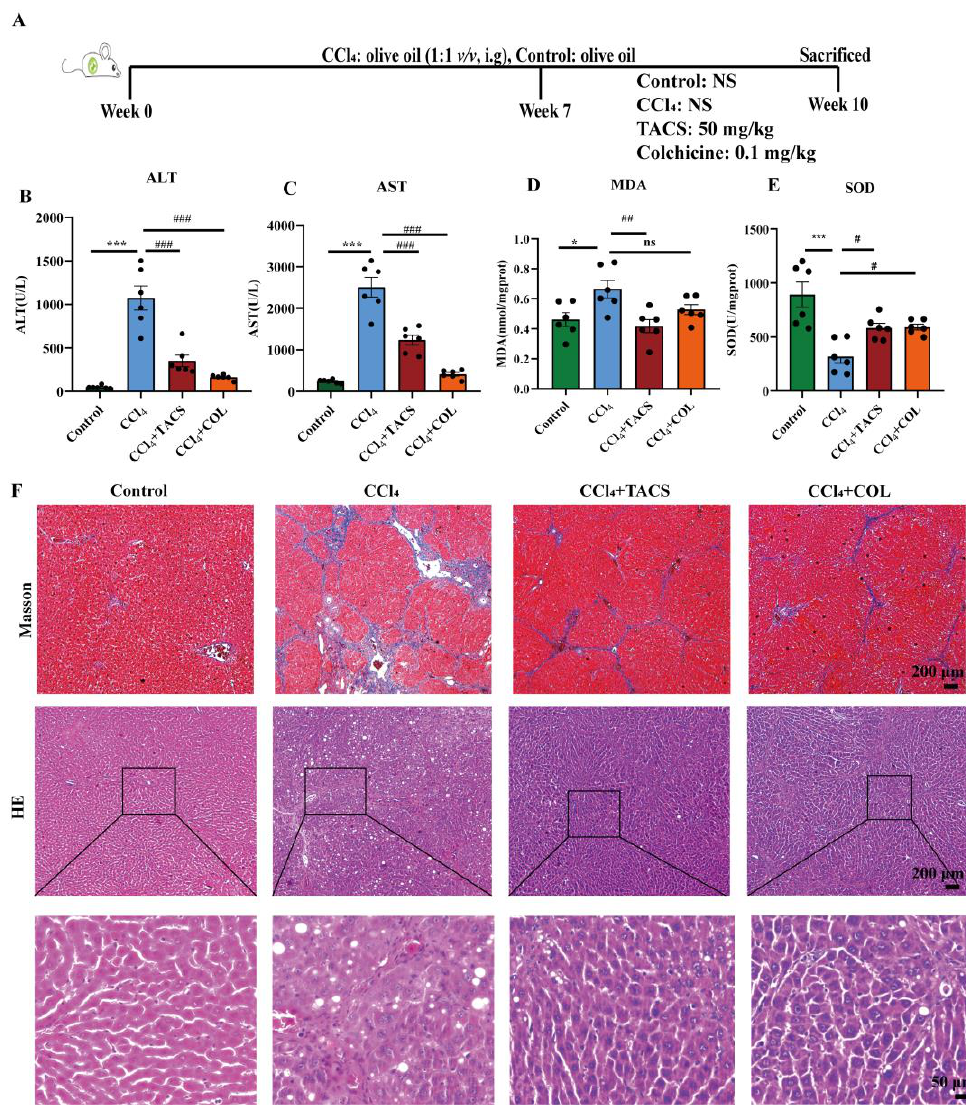
Figure 1. Effects of TACS on liver fibrosis in CCl 4 -induced rats. ( A ) Animal experiment design ( B , C ) The serum of ALT and AST levels ( n = 6). ( D , E ) The liver of MDA and SOD levels ( n = 6). ( F ) Representative Masson and H&E staining of liver tissue photos. Data were expressed as the mean ± SEM. * p < 0.05, *** p < 0.001 vs. control group; # p < 0.05, ## p < 0.01, ### p < 0.001 vs. CCl 4 -treated group, ns represents no significance.